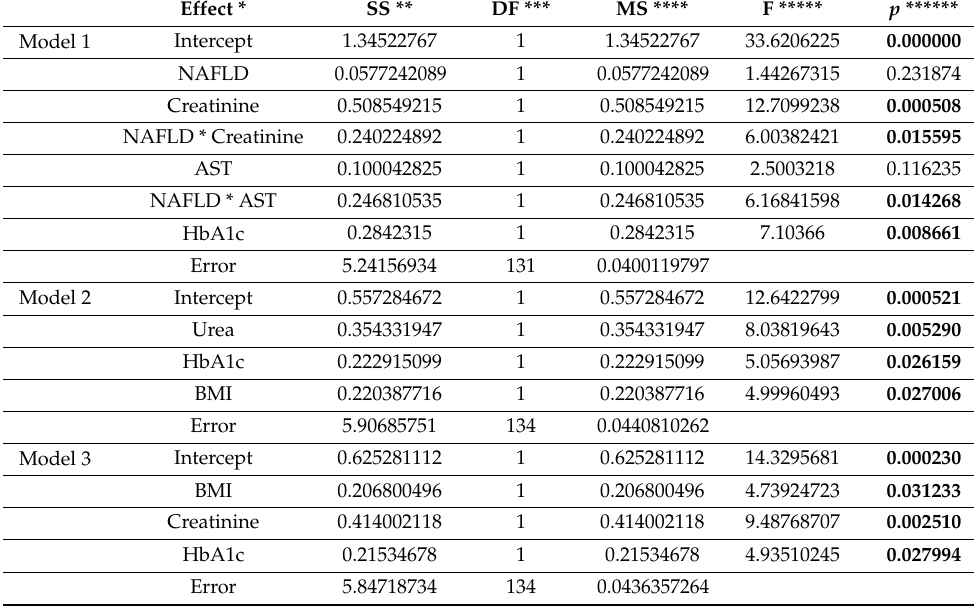
Table 4. Results of the general linear model (GLM) for irisin concentration and NAFLD status (with interactions). The models with a sigma-restricted parameterization; effective hypothesis decomposition, ANOVA and ANCOVA